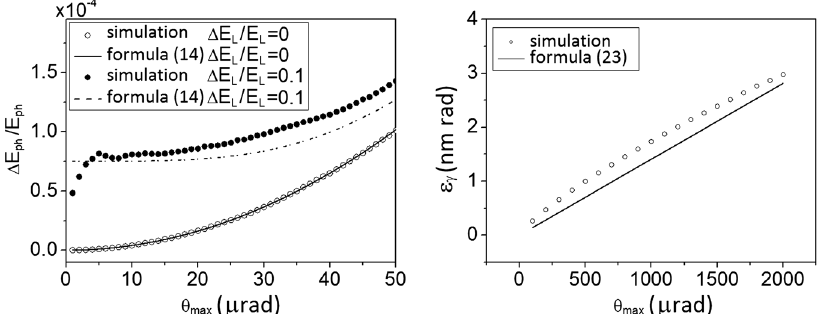
=E value from CMCC simulation vs formula (14) as a function of θ ph ph γ (nm rad) value from CAIN simulation vs formula (23) as a function of